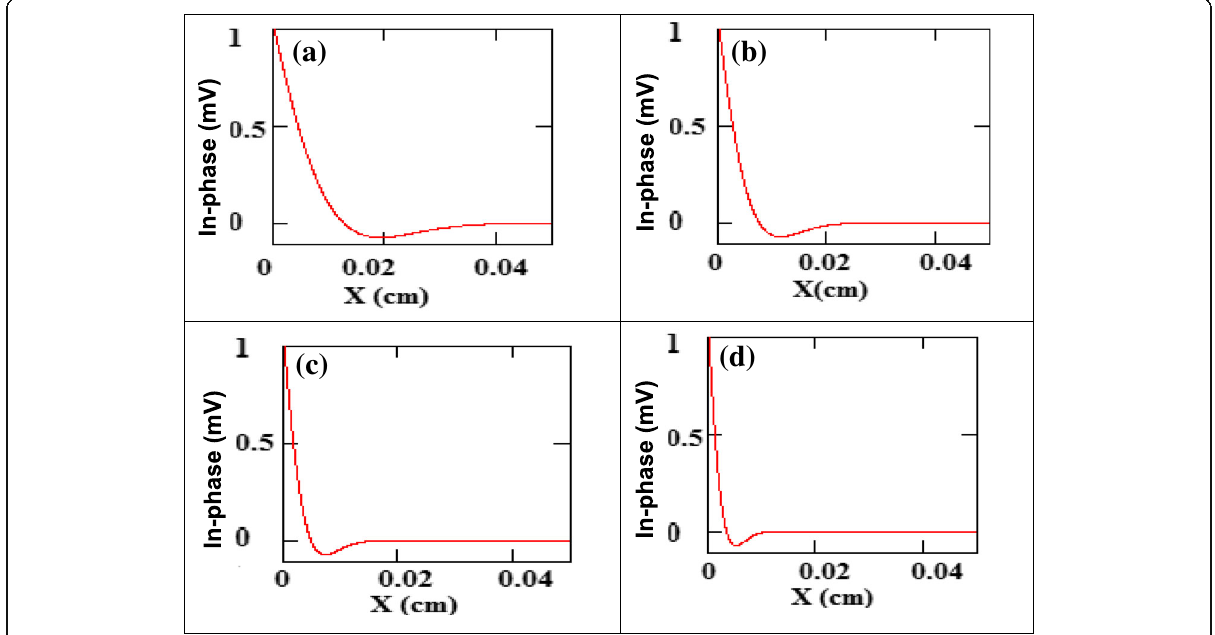
Fig. 4 The real (in-phase) part of PE signal vs relative cavity length for water at different frequencies: a 7Hz, b 20Hz, c 50 H, and d 100Hz, thermal diffusivity of water ( α w ,=0.00145cm 2 .s − 1